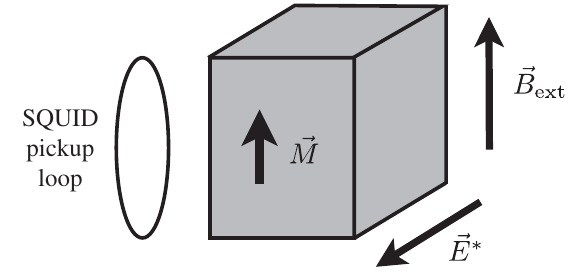
FIG. 1. Geometry of the experiment. The applied magnetic field ~B is colinear with the sample magnetization ~M . The effective ext electric field in the crystal ~E SQUID pickup loop is arranged to measure the transverse magnetization of the